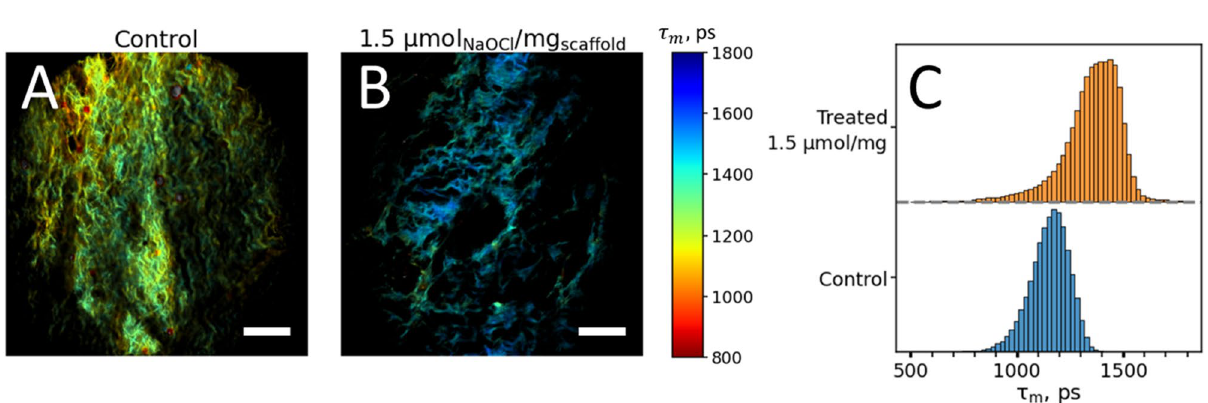
Figure 2. Fluorescence decay parameters of DBP-G scaffolds incubated with neutrophils. ( A , B ) Average fluorescence lifetime (τ m ) maps of control DPB-G scaffold ( A ) and DPB-G scaffold incubated with neutrophils additionally activated with PMA ( B ). ( C ) Histogram distributions of the average fluorescence lifetime τ m for control and treated DPB-G samples. Fluorescence was excited at 800 nm and detected in the 350–680 nm range. Scale bars in panels ( A ) and ( B ) are equal to 150 µm.